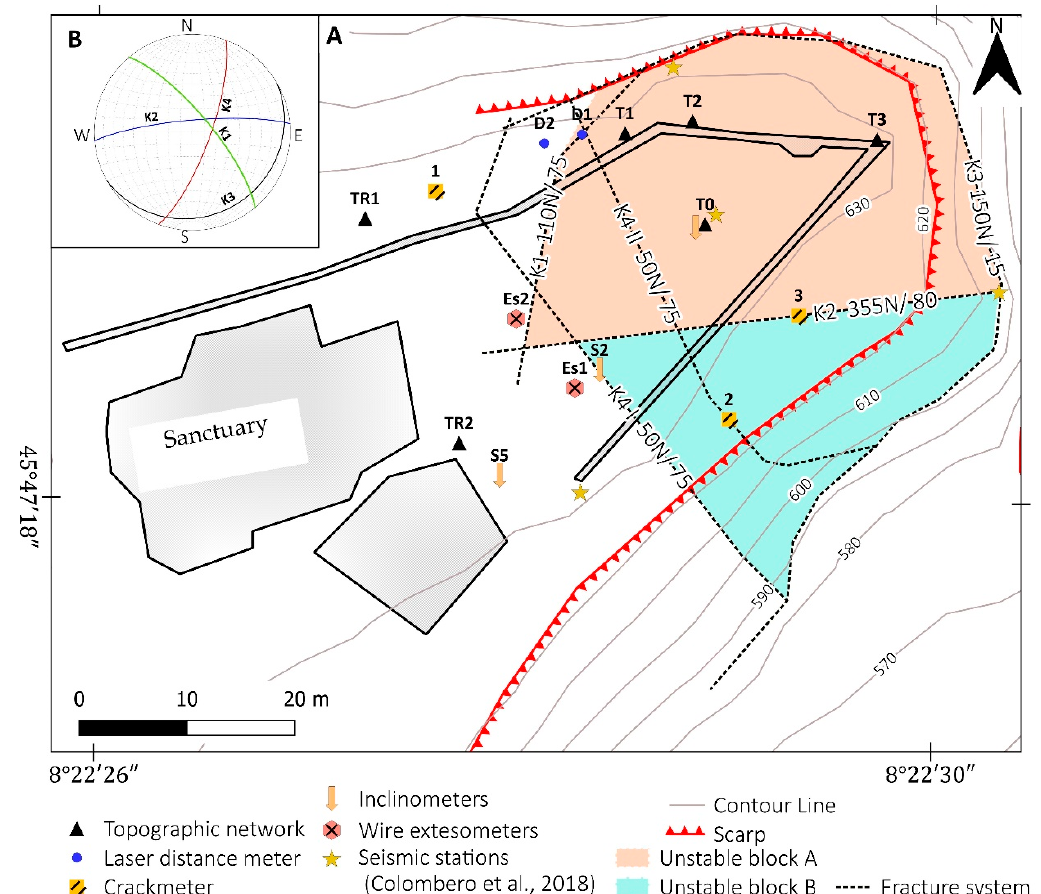
Figure 3. ( A ) detail of the fracture systems that limits the unstable blocks ( A ) and ( B ), based on results reported in [18,21]. The map also reports former and current monitoring systems installed by ARPA and Regione Piemonte on Madonna del Sasso site, together with seismic stations used by [27]; ( B ) shows the stereonet of the fracture system.